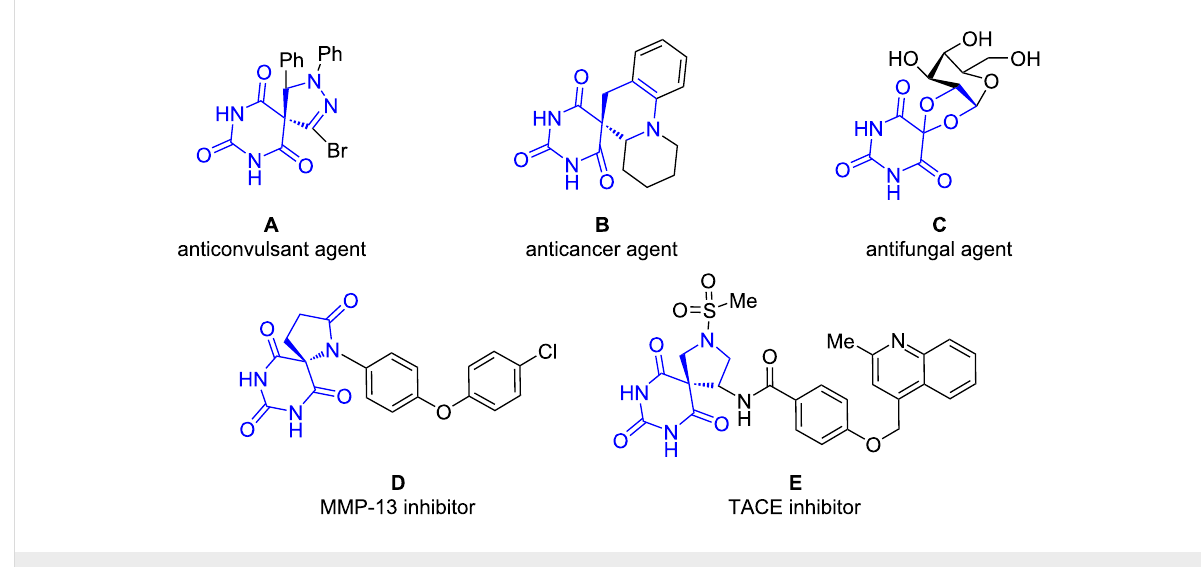
Figure 2: Selected examples of bioactive spirobarbiturates.